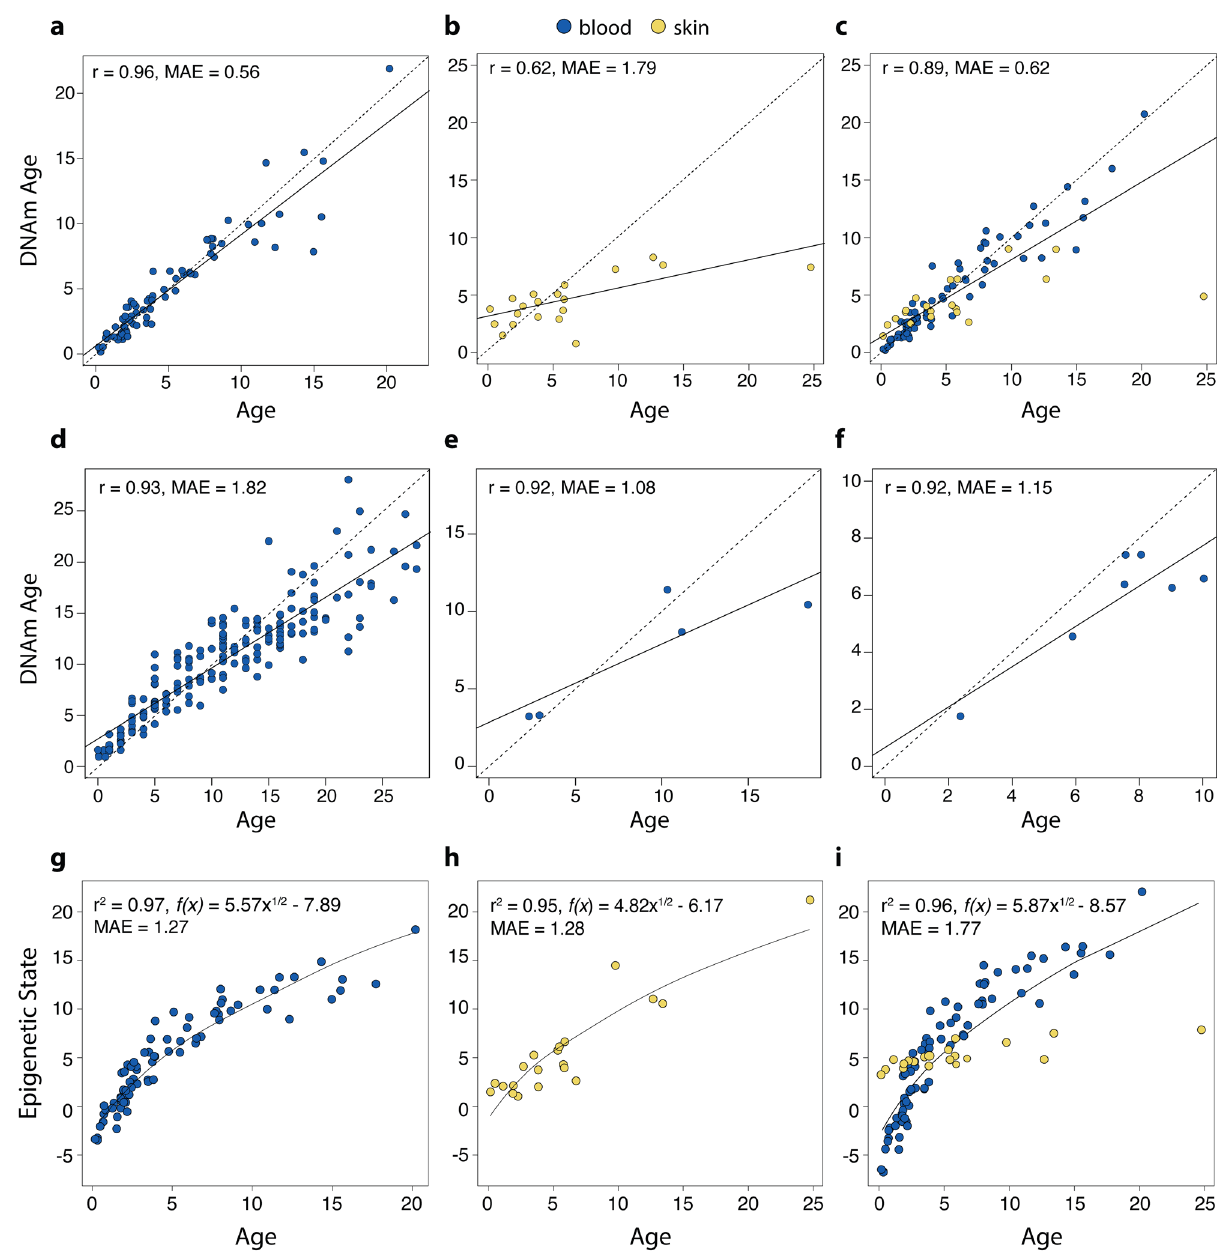
Fig. 1 Predictive ability of epigenetic aging models. a − c Plains zebra epigenetic clocks (EC). We developed 3 ECs for plains zebras using square-root transformed ages: a blood samples ( n = 76), b biopsy samples ( n = 20), and c combined tissue types. Leave-one-sample-out (LOO) estimate of DNA methylation age are plotted against chronological age. Linear regressions of epigenetic age are indicated by a solid line while the diagonal dashed line depicts y = x . d – f Tests of the ability of the plains zebra blood clock to predict chronological age in other equids: d domestic horse n = 188, e Grevy ’ s zebra n = 5, f Somali wild ass n = 7. g – i Epigenetic pacemaker (EPM) models for plains zebras. Epigenetic states (or epigenetic age) of plains zebras predicted from the EPM using g blood ( n = 76), h remote biopsy tissue ( n = 20), and i both sample types combined. Predictions are based on 76 blood samples and 20 biopsy samples. The equation of the fi tted curve (solid line) is described for each plot. MAE are based on ages translated by the